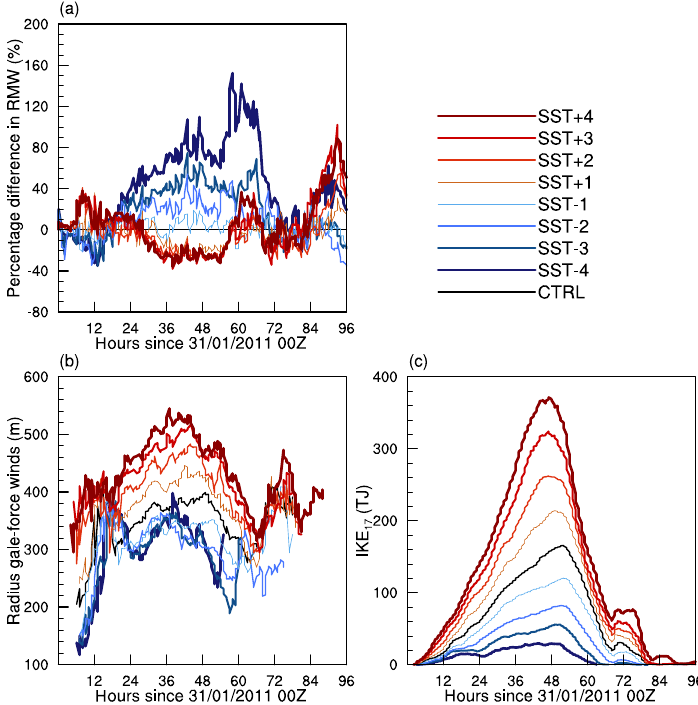
Figure 5. (a) Percentage difference between radius of maximum winds in SST experiments and CTRL run (%). (b) Radius to gale-force winds (m) and (c) integrated kinetic energy (TJ) at wind speeds > 17.5ms − 1 for all model simulations.